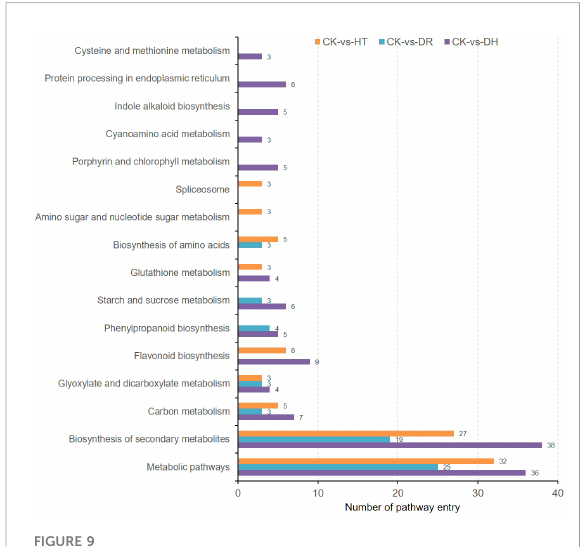
FIGURE 9 KEGG pathway analysis of co-expressed DEGs and DEPs under HT, DR, and DH